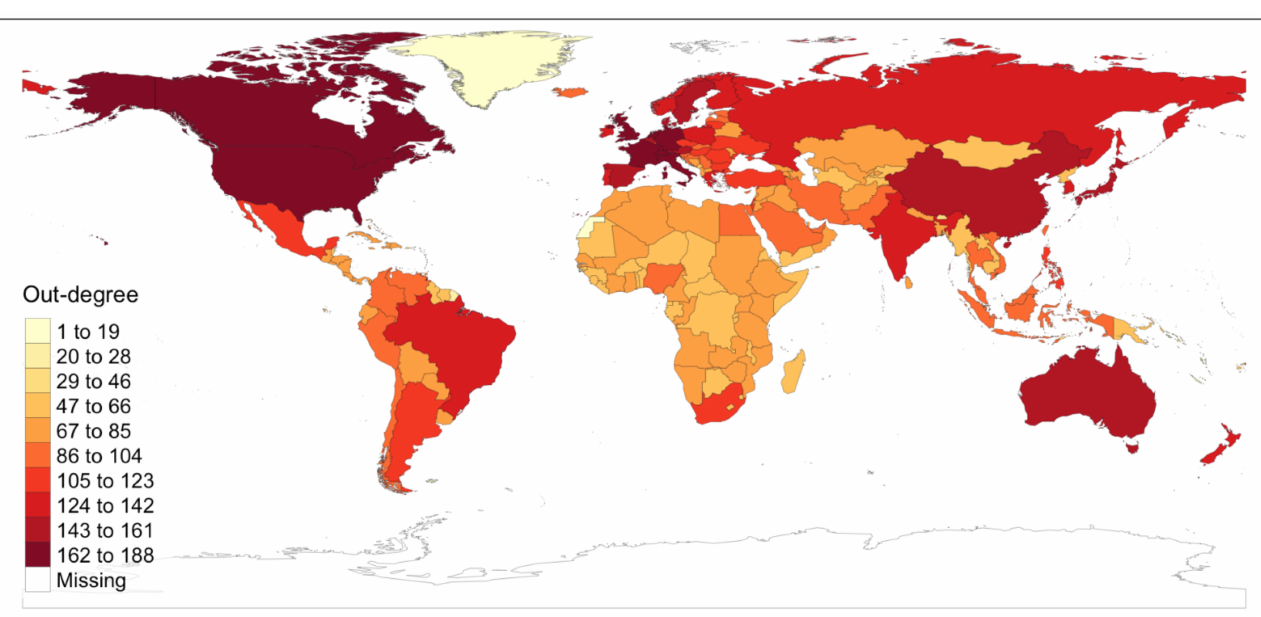
Figure 3. Out-degrees. Source: